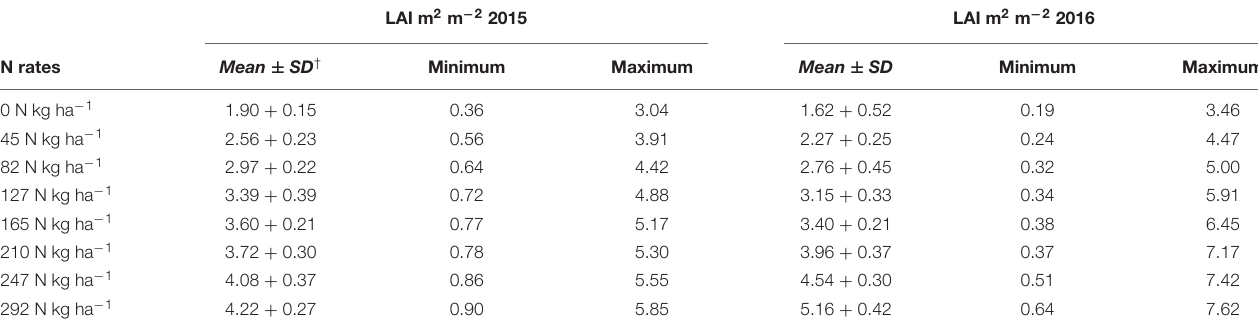
TABLE 3 | Summery statistics of leaf area index (LAI) at phenological stages under different nitrogen rates in 2015 and